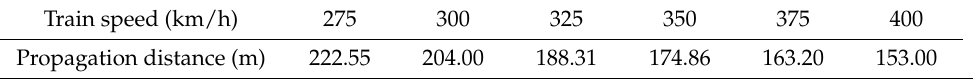
Table 1. Propagation distances of initial pressure waves at different train speeds in Stage I.